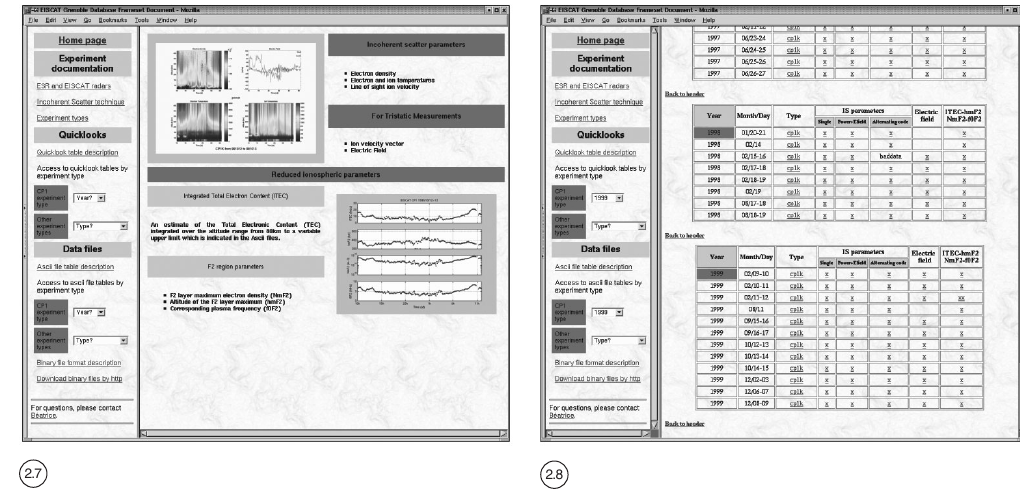
Fig. 2.7. Start page of the EISCAT database. Fig. 2.8. Selecting data from the EISCAT